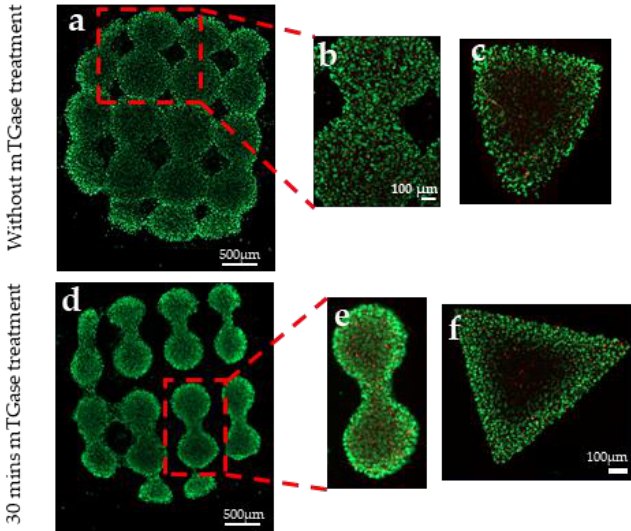
Figure 8. Micropatterned cell-laden gels created using photolithography ( a ) dumbbell patterns, ( b ) zoomed in view of dumbbell pattern, ( c ) triangular pattern, ( d ) dumbbell patterns, ( e ) zoomed in view of dumbbell pattern, ( f ) triangular pattern.